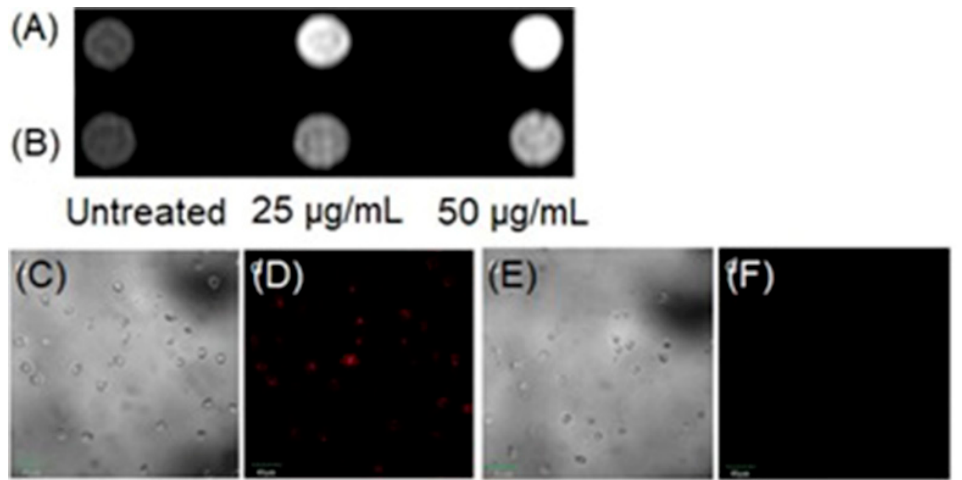
Figure 25. ( A ) T 1 -weighted MRI images of CCRF-CEM (hypoxic tumor cell line) cells and ( B ) Ramos (normoxic cell line) cells incubated with nanosheet at various concentrations in media for 3 h. Once MnO 2 nanosheets are endocytosed and reduced by glutathione, Mn II ions are produced. As a result, enhancement in T 1 -weighted MRI images was observed in hypoxic cells compared to normoxic cells. ( C , D ) Confocal microscopic images of CCRF-CEM cells treated with nanosheets. ( E , F ) Confocal microscopic images of Ramos cells treated with nanosheets. Red fluorescence was observed in the CCRF-CEM cells compared to Ramos cells after treated with nanosheets, indicating the fluorescence response of the nanosheets was activated in hypoxic cells. Adapted with permission from Zhao, Z.;